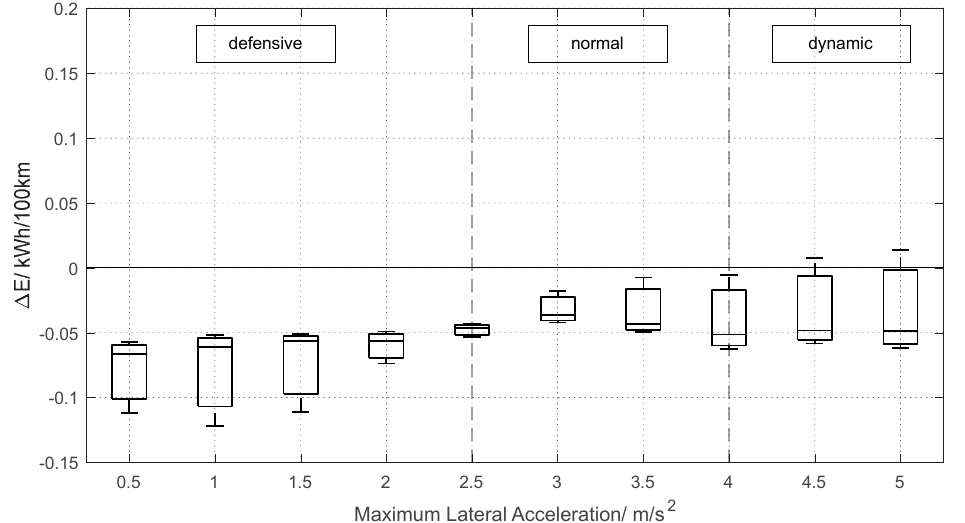
Figure 11. Comparison of energy demands between e 2 ‐ Lenk and conventional steering assistance systems as a function of lateral acceleration (classification of types of drivers in accordance with [16,17]). The line in a box represents the median of the data values.